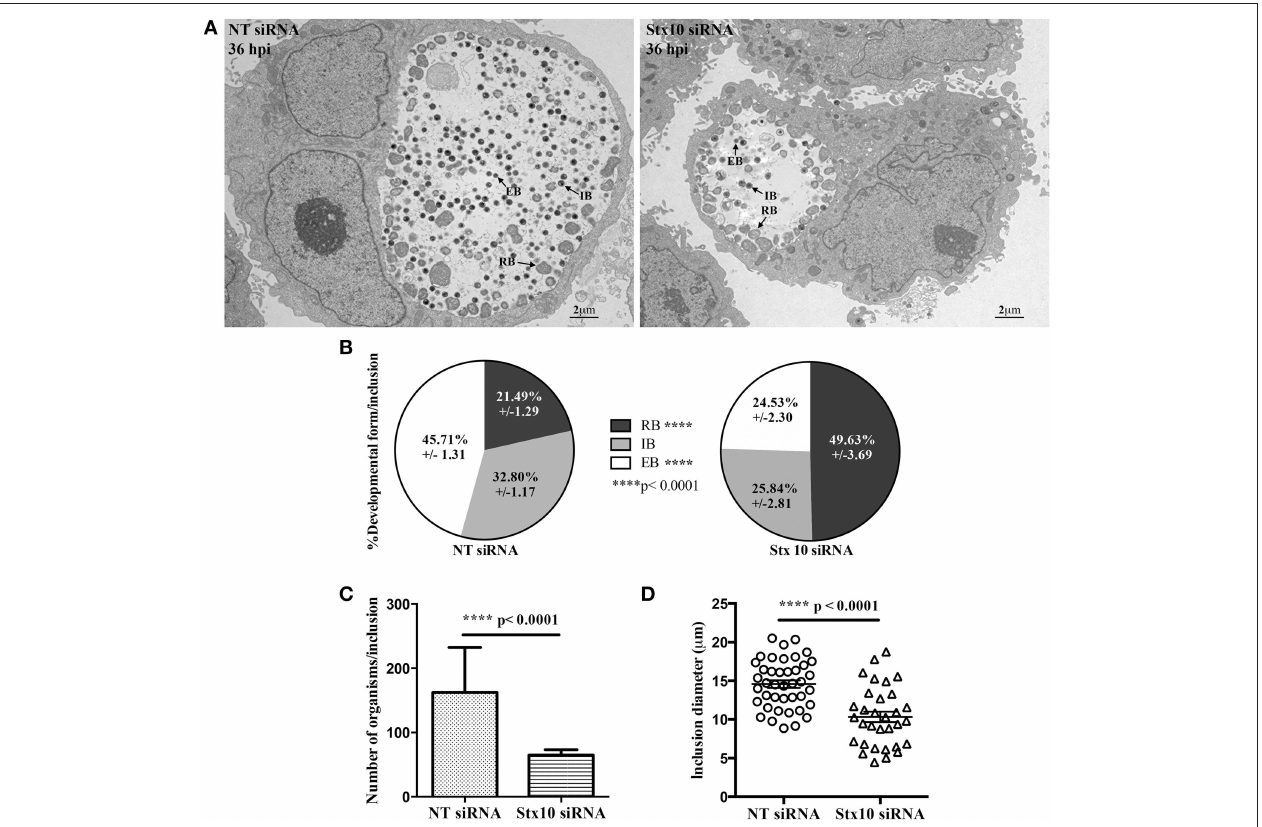
FIGURE 4 | Transmission electron micrograph analysis of the effect of syntaxin 10 siRNA knockdown on chlamydial development. Syntaxin 10 (Stx10) or non-targeting (NT) siRNA-treated HeLa cells were infected with C. trachomatis serovar L2 for 36h and then processed for transmission electron microscopy as described in Materials and Methods. For these studies, 40 images each from either Stx10 or NT-siRNA treated cells from 2 independent experiments were examined. Representative images are shown in (A) and Supplemental Figure 1. These images were used to quantify chlamydial developmental forms (B) , total numbers of organisms per inclusion (C) , or inclusion diameter (D) . All values were graphed to display the mean and standard error of the mean using GraphPad Prism 6 software. Statistical analysis included ordinary One-Way ANOVA with Tukey’s multiple comparison test (B) and Student’s t -test (C,D)